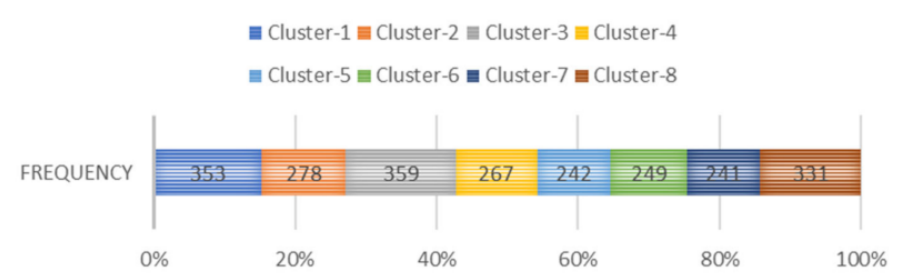
Figure 10. The numbers of the clusters.